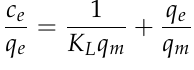
Figure 5. OFX adsorption isotherm on ZIF-8 ( a ) and Cu-ZIF-8-1 ( b ) ( m = 5 mg; V = 10